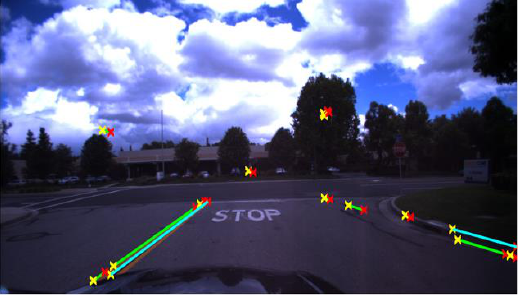
Figure 16. Line segments detected on image